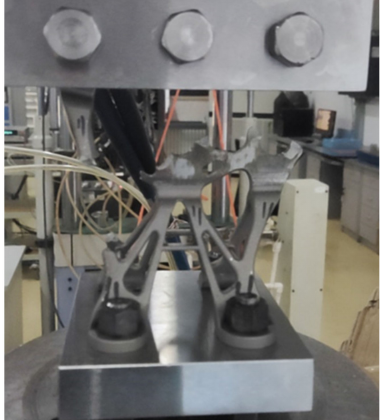
Figure 16. New bracket fracture during the fatigue test by